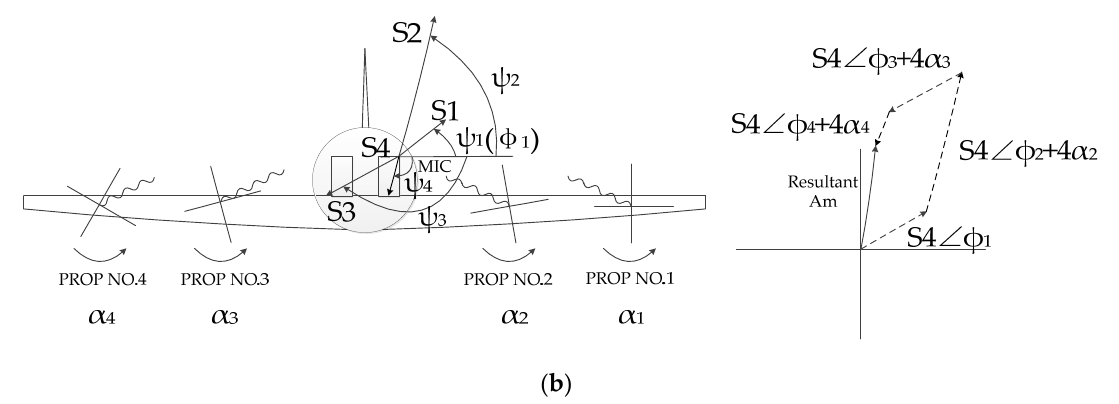
Figure 1. Propeller signature schematic diagram: ( a ) phase angle pair of { 0 ◦ ,0 ◦ ,0 ◦ ,0 ◦ } ; ( b ) phase angle pair of { 0 ◦ , α 2 , α 3 , α 4 }